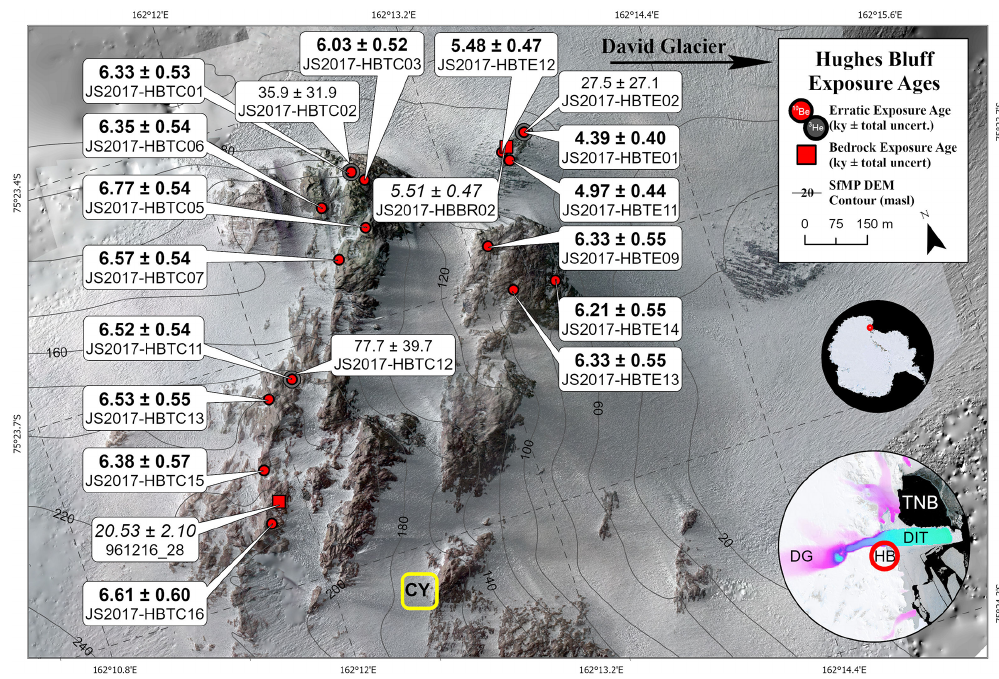
Figure 5. Orthomosaic map of Hughes Bluff with all exposure ages, 10 Be (red) and 3 He (grey), and total errors listed. Erratics and bedrock ages plotted as circles and squares, respectively. Bold ages indicate Holocene age erratics, and italicised ages indicate bedrock exposure. Large inset shows ice surface velocity of Rignot et al. (2011), and small inset shows LIMA data of Bindschadler et al. (2008). DG: David Glacier; DIT: Drygalski Ice Tongue; TNB: Terra Nova Bay; HB: Hughes Bluff; CY: Camp Yellow.